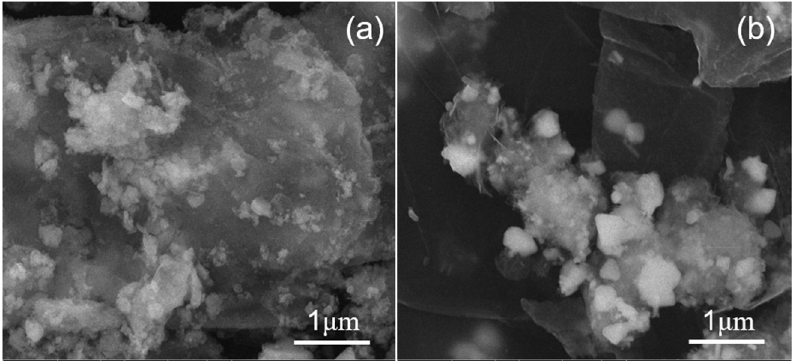
Figure 12. SEM images for ( a ) a holding time of 1 h and ( b ) 10 mL of deionized water.